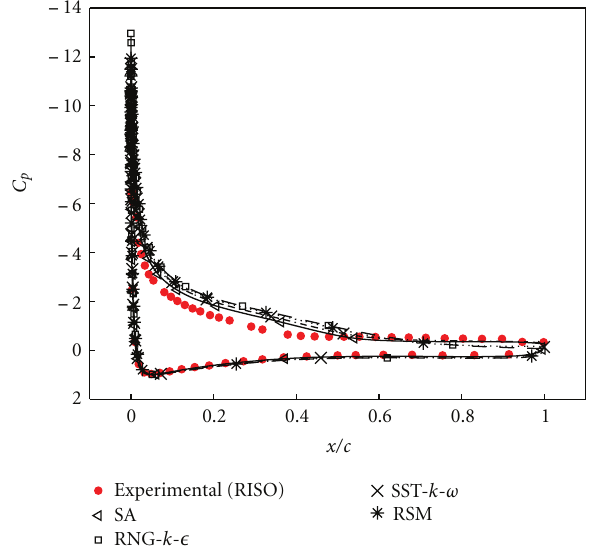
Figure 7: Pressure coe ffi cient at 16 ◦ following application of various turbulence